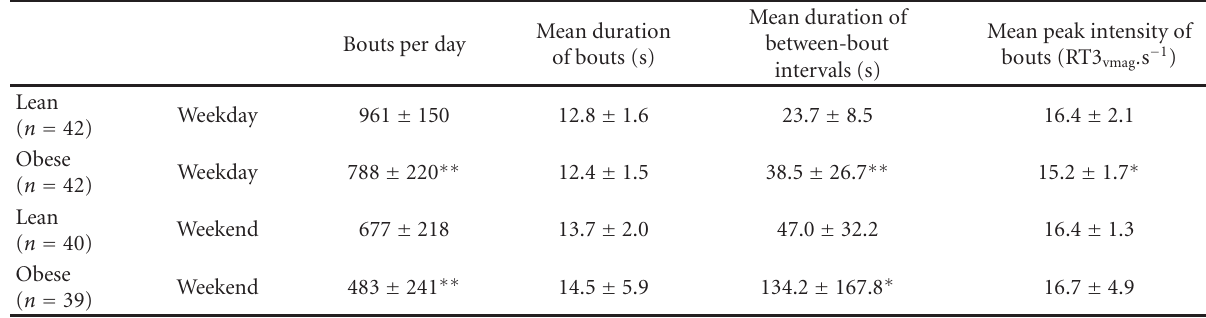
Table 2: Activity pattern characteristics during school days and at the weekend in lean and obese Chinese children. Bouts per day